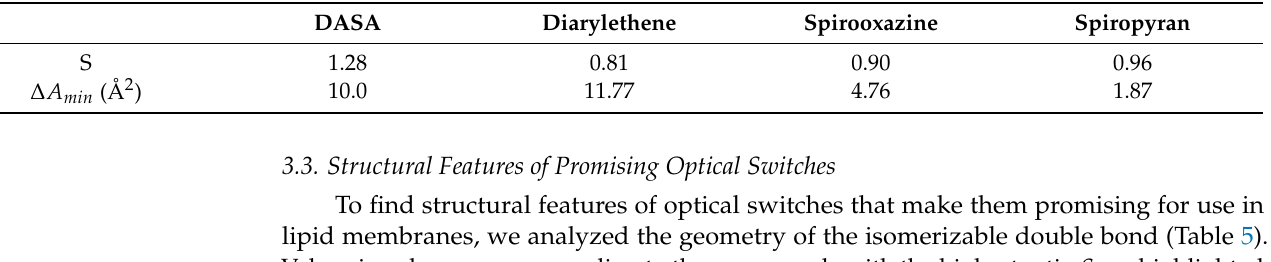
Table 4. Change of the geometry upon the open/closed transition.